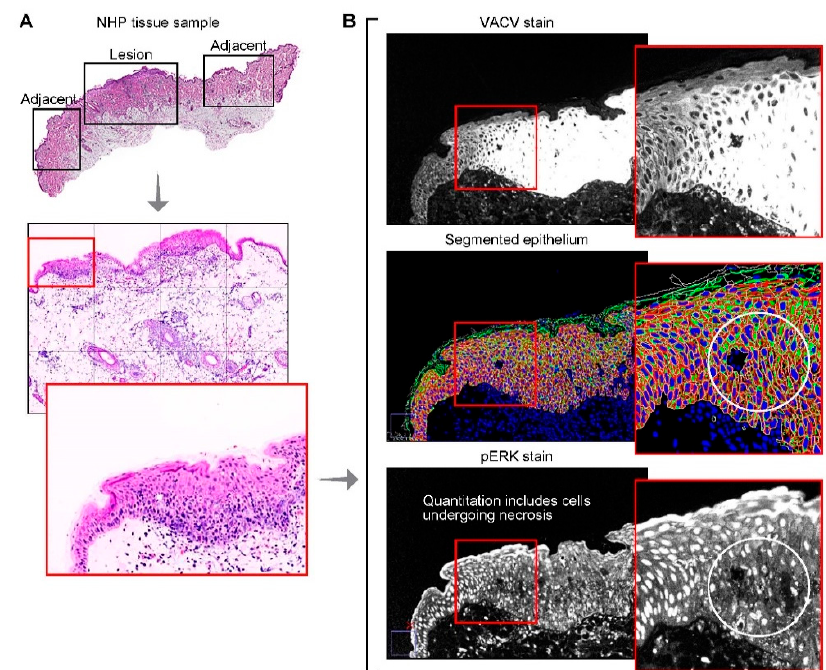
Figure 4. Multiplex immunofluorescence, segmentation and quantification. A potential cause of the discrepancy between semiquantitative manual IHC score and automated quantification of pERK1 / 2 is the inclusion of successfully segmented, but nonviable cells when using Cell DIVE. ( A ) H&E of monkeypox virus-lesioned skin and adjacent, uninfected skin annotated by a pathologist (top); H&E of the lesion included in the automated quantification (middle); H&E of a single field of view within the lesioned skin (bottom). ( B ) MPXV-staining in the field of view shown in (A) (top); Automated cellular / subcellular segmentation using compartment and region-specific cell markers (middle, bottom); ERK1 / 2 pT202_pY204-staining indicated loss of ERK1 / 2 pT202_pY204 in nonviable cells